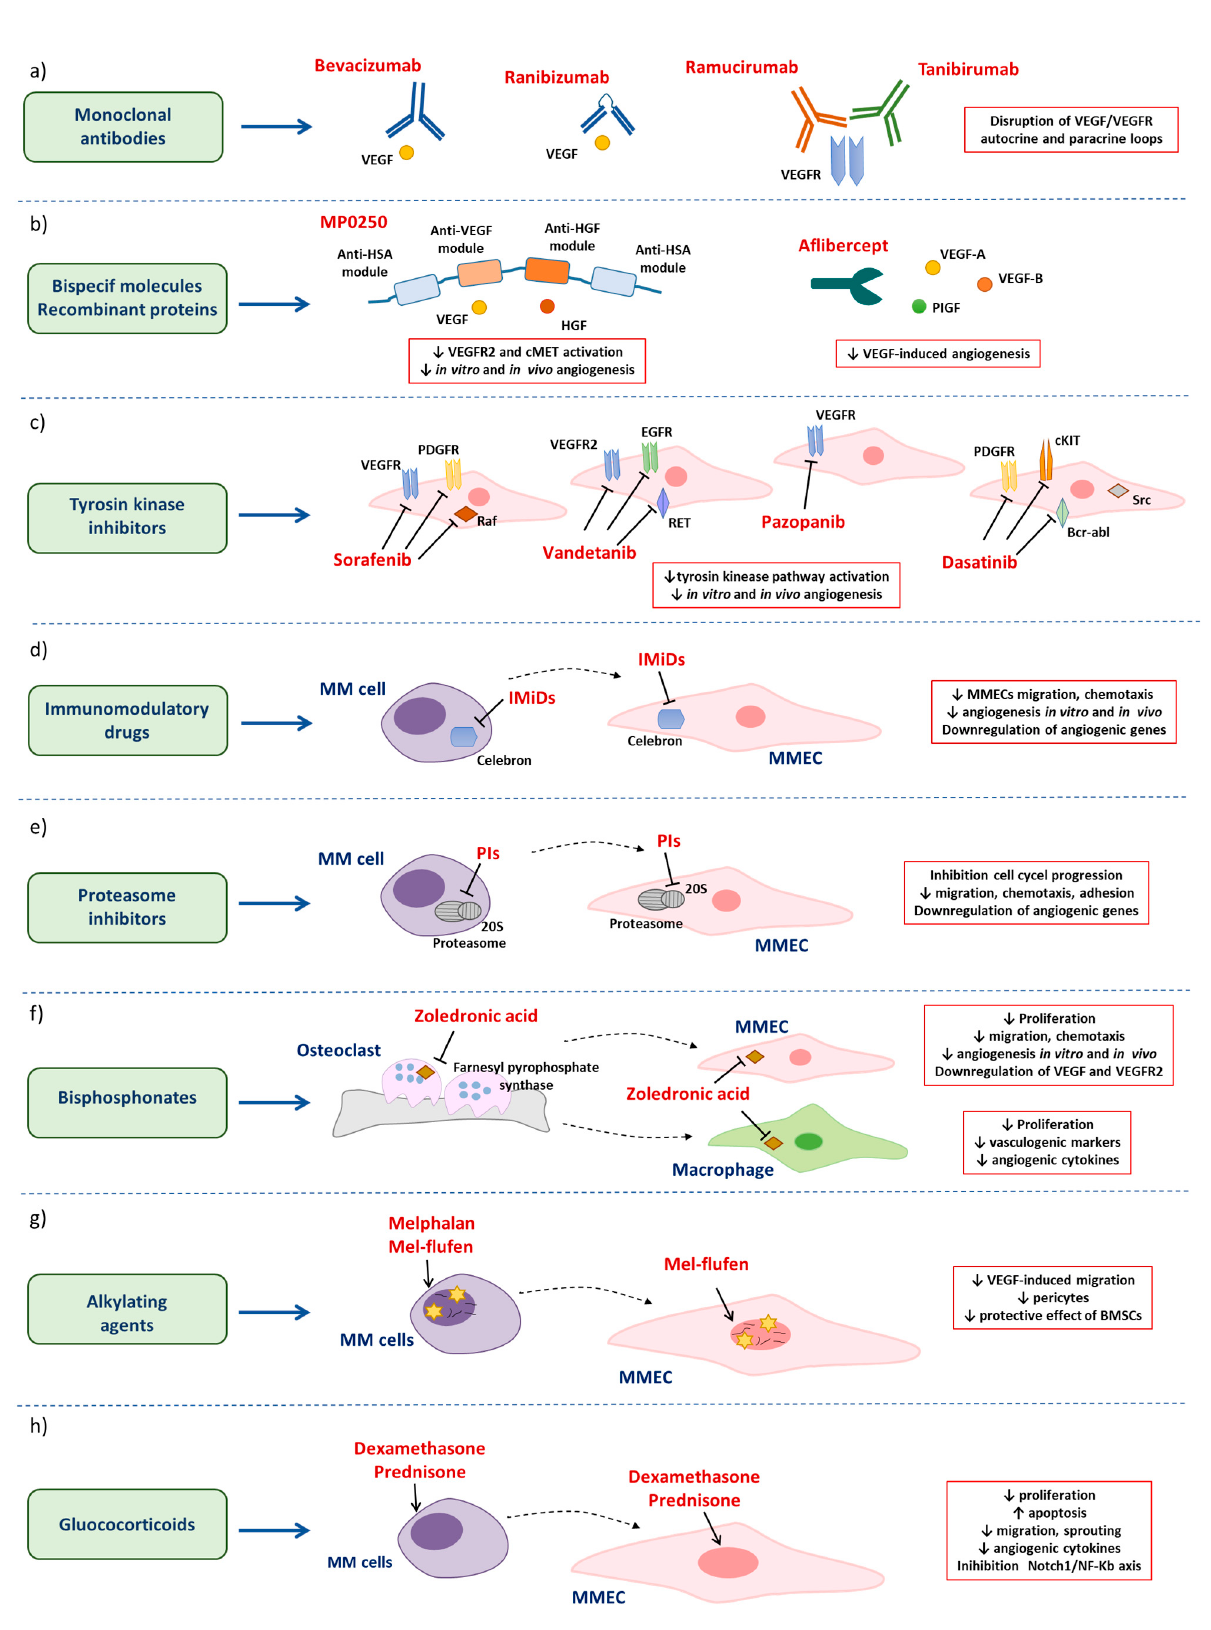
Figure 2. Graphical representation of the main drugs with a direct and indirect anti-angiogenic effect in MM: ( a ) monoclonal antibodies; ( b ) bispecific molecules and recombinant proteins; ( c ) tyrosin kinase inhibitors; ( d ) immunomodulatory drugs; ( e ) proteasome inhibitors; ( f ) bisphosphonates; ( g ) alkylating agents; and ( h ) glucocorticoids. Detailed description in the main text.